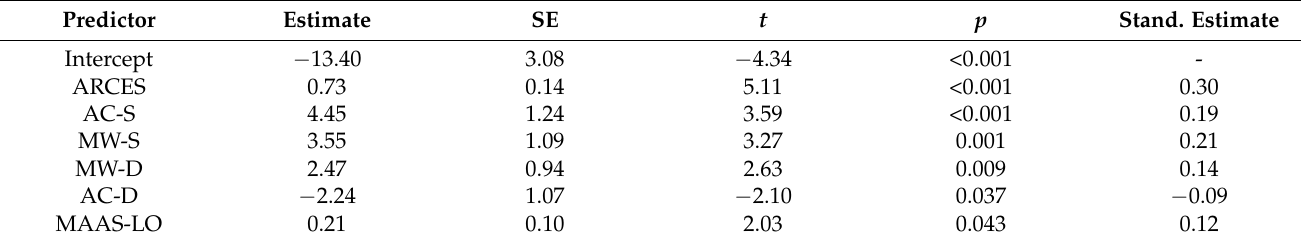
Table 3. Summary of initial standard multiple regression analysis for attentional predictors of phubbing behavior ( N = 373).